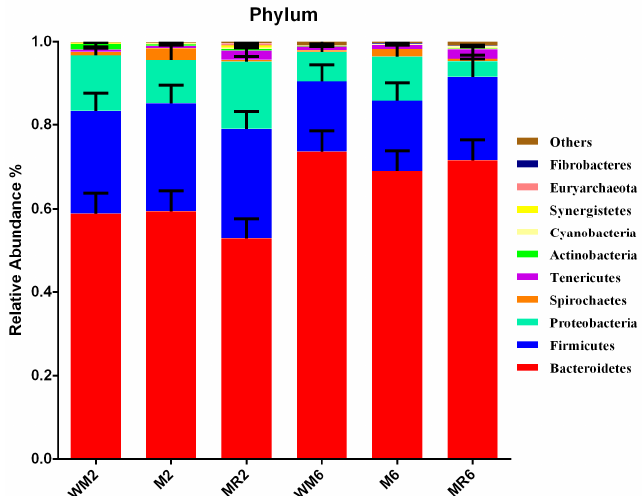
Figure 3. Relative abundance of rumen bacteria at the phylum level. The 10 most abundant phyla